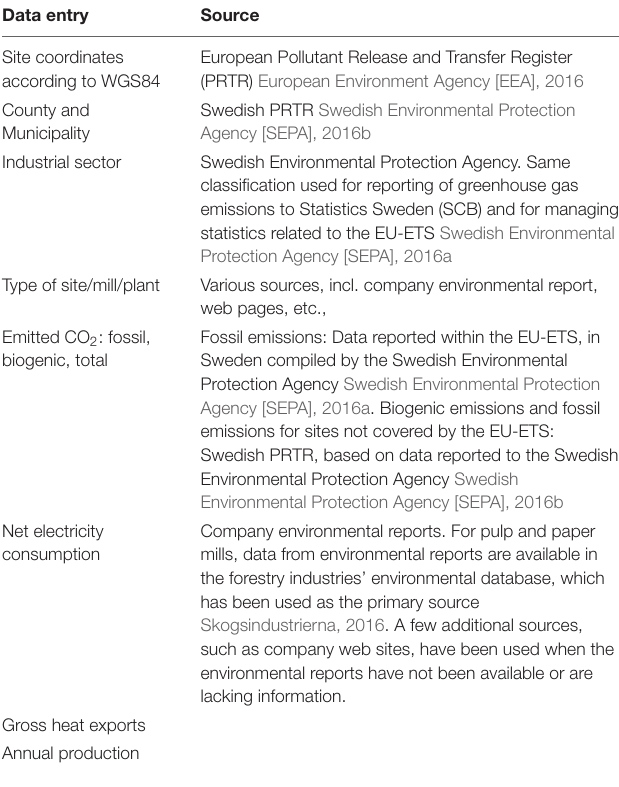
TABLE 1 | Publicly available data categories summarized for all industry sites in the ChICaSP data